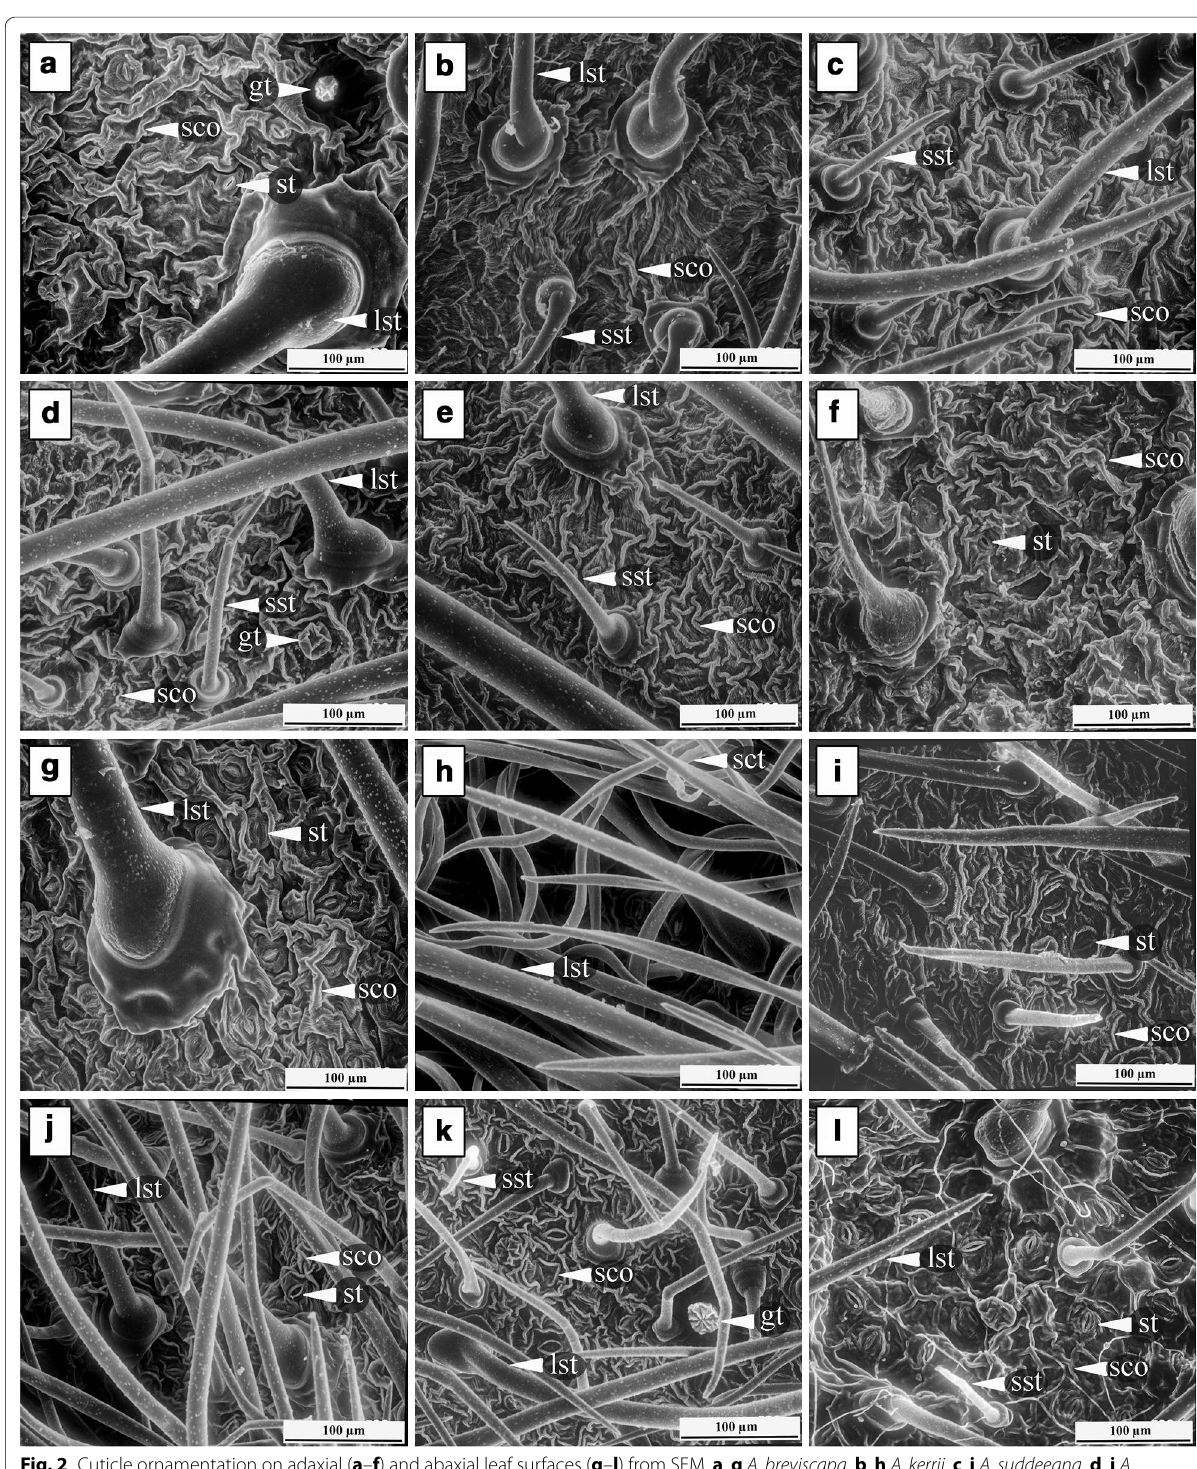
Fig. 2 Cuticle ornamentation on adaxial ( a – f ) and abaxial leaf surfaces ( g – l ) from SEM. a , g A. breviscapa , b , h A. kerrii , c , i A. suddeeana , d , j A. variabilis , e , k Argyreia 1 and f , l Argyreia 2 ( gt glandular trichome, lst large straight trichome, sst small straight trichome, sct small curly trichome, st stomata, sco striate cuticular ornamentation). Scale bar 100